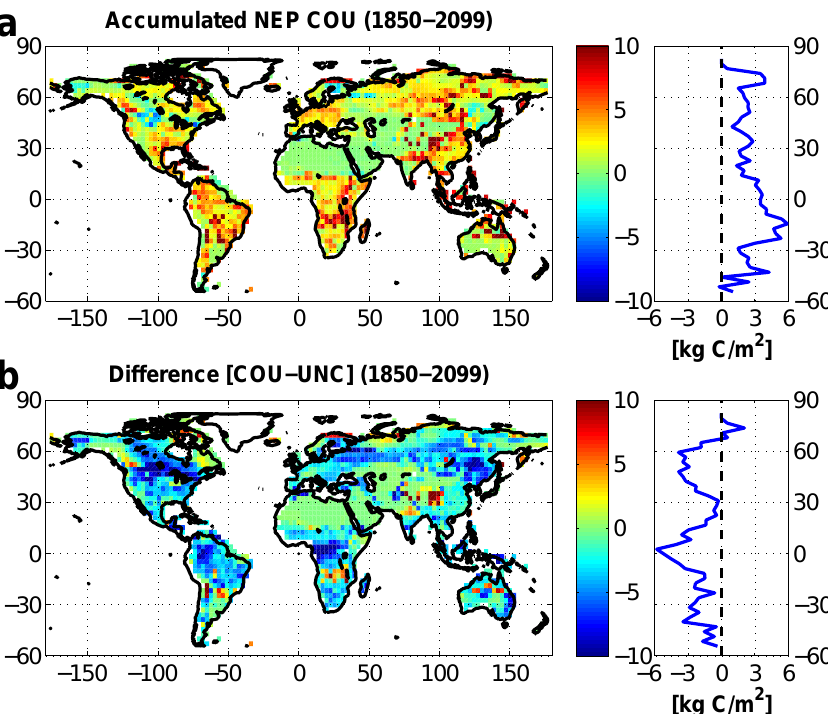
Fig. 6. Geographical distribution of accumulated carbon uptake by the land [PgC] (top) simulated by the COU simulation and (bottom) the difference between COU and UNC simulations. The right panel shows the latitudinal average of carbon uptake [kgC/m 2